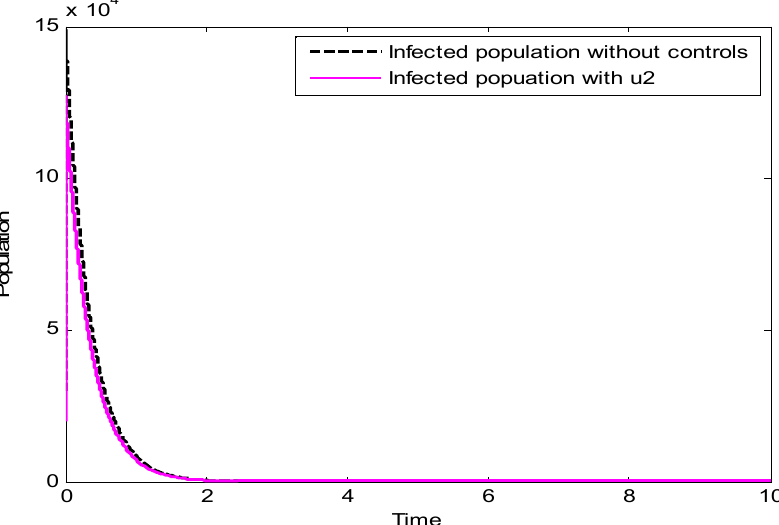
Figure 4. Comparing the dynamics of the infected population without control and with control u 2 .